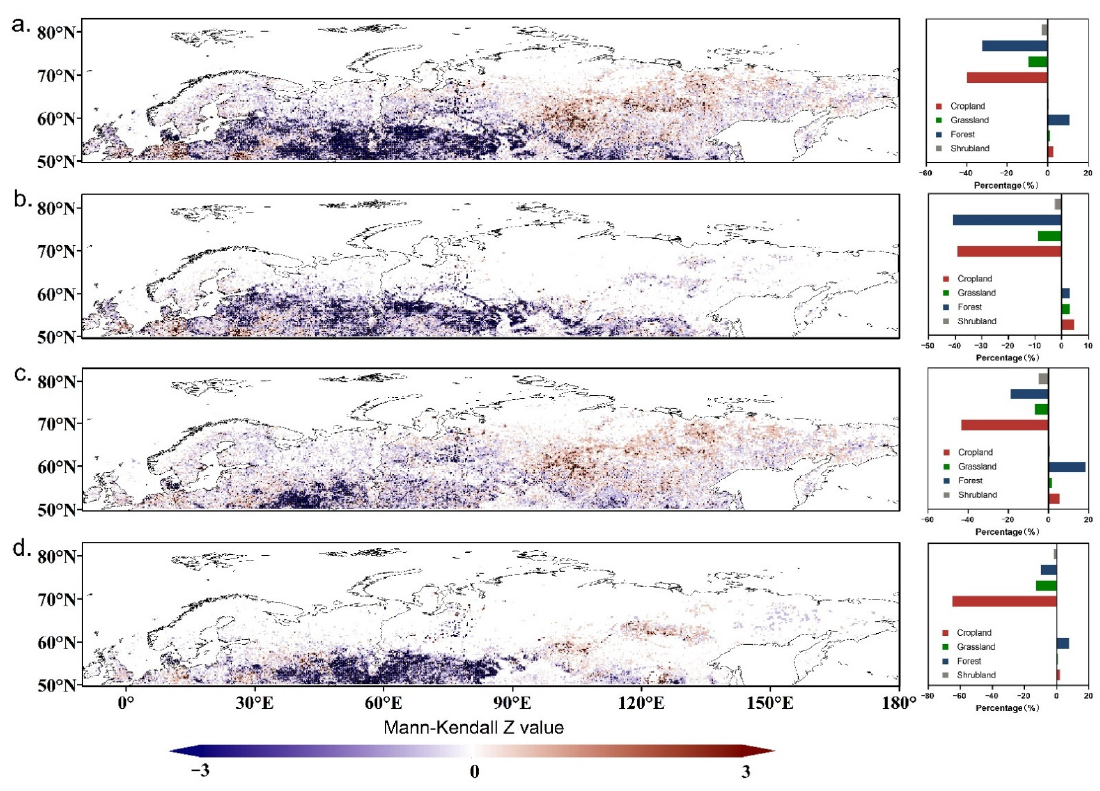
Figure 6. Spatial distributions of annual ( a ), spring ( b ), summer ( c ), and autumn ( d ) non-parametric statistical trends in fire count from 2003 to 2020. Pixels marked with black dots indicate trends with 90% confidence levels. Percentages of pixels with 90% confidence levels are shown on the right.